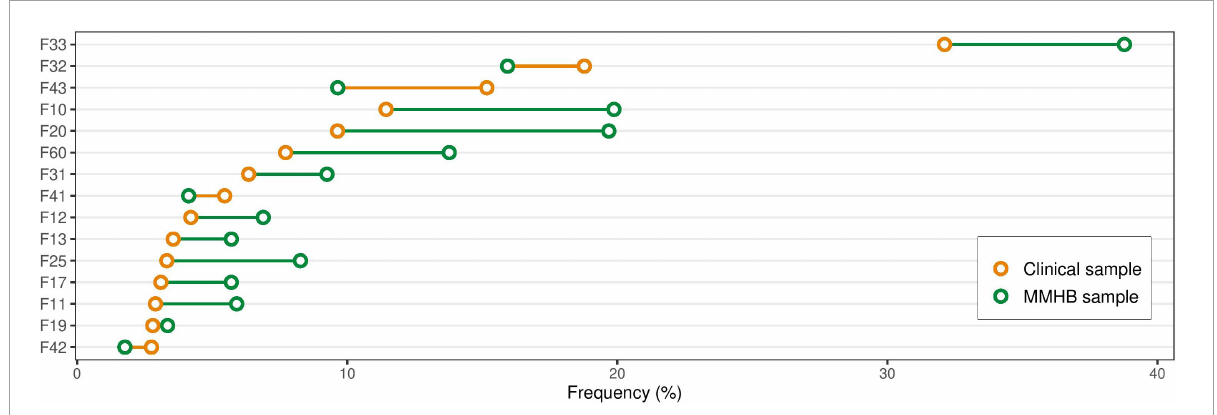
FIGURE2 Differences in diagnosis frequency between the Munich Mental Health Biobank (MMHB) and Clinical samples. Comparison of the prevalence of the 15 most frequent diagnoses derived from the Clinical sample in the Munich Mental Health Biobank and the Clinical sample. The diagnoses were defined as all (independent) clinical (ICD-10) diagnoses the patient received during the observational period (11 April 2019 to 31 October 2021). A full list of diagnoses and their respective frequencies is provided in Supplementary Table 3 . F33, recurrent depressive disorder; F32, depressive episode; F43, adjustment disorder; F10, alcohol-related disorders; F20, schizophrenia; F60, personality disorders; F31, bipolar disorder; F41, other anxiety disorders; F12, mental and behavioral disorders due to use of cannabinoids; F13, mental and behavioral disorders due to use of sedatives or hypnotics; F25, schizoaffective disorder; F17, mental and behavioral disorders due to use of tobacco; F11, mental and behavioral disorders due to use of opioids; F19, mental and behavioral disorders due to multiple drug use and use of other psychoactive